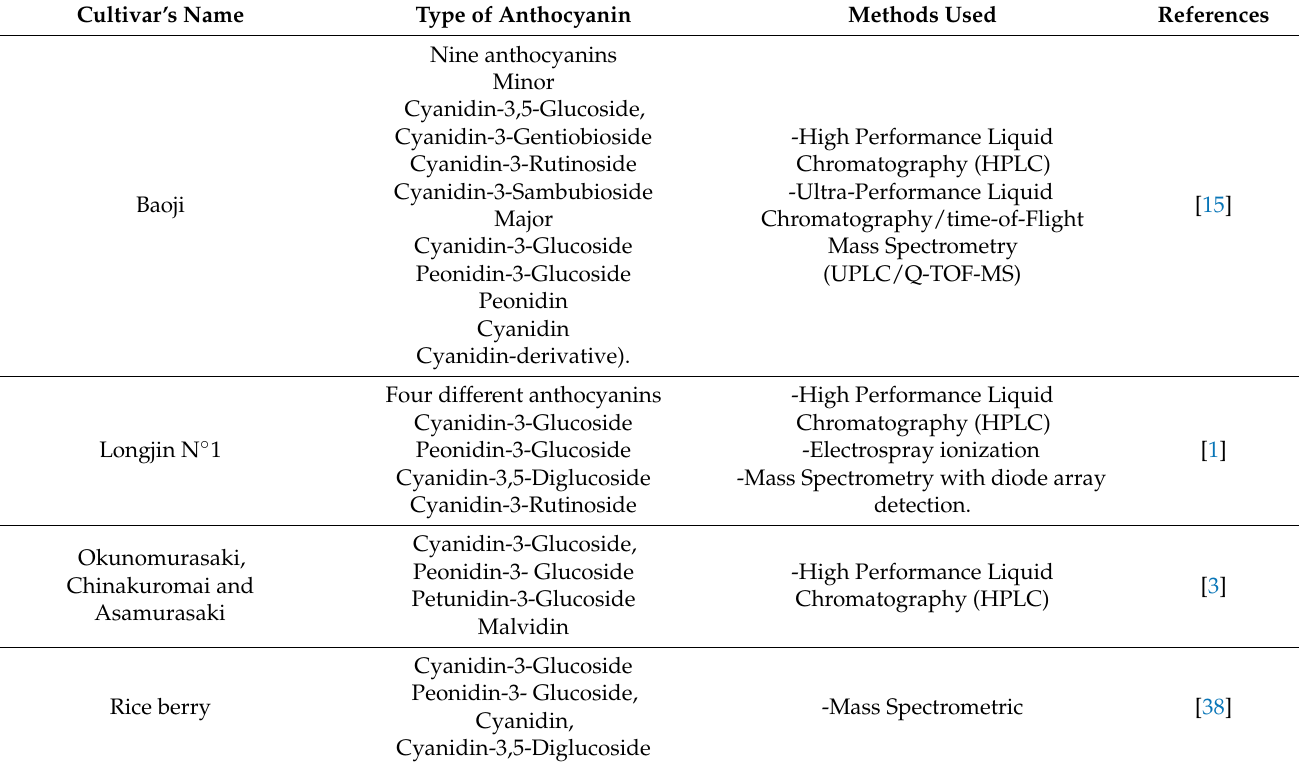
Table 2. Identification of different anthocyanins in black rice